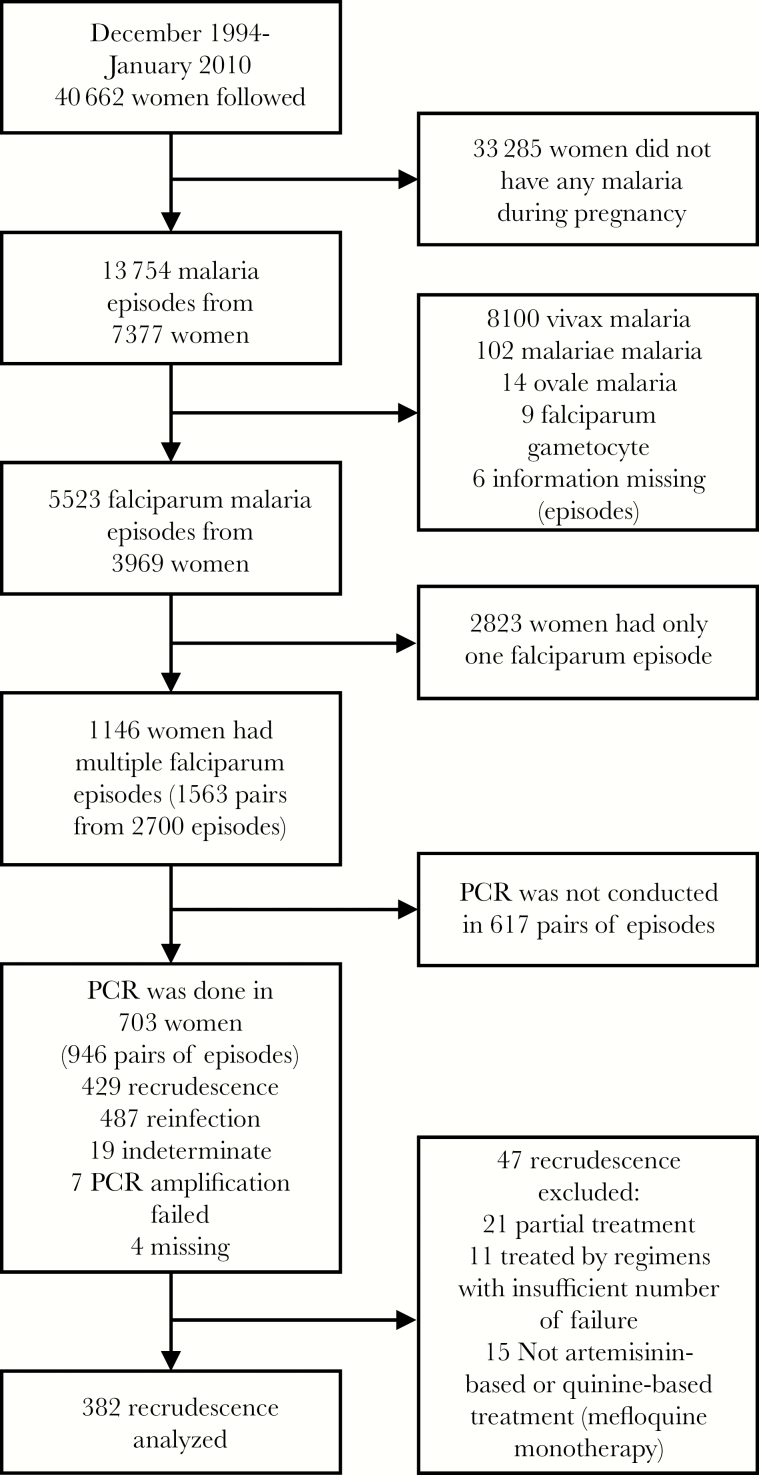
Number of recurrent malaria episodes in pregnant women attending antenatal care on the Thailand–Myanmar border, 1994–2010. Abbreviation: PCR, polymerase chain reaction.